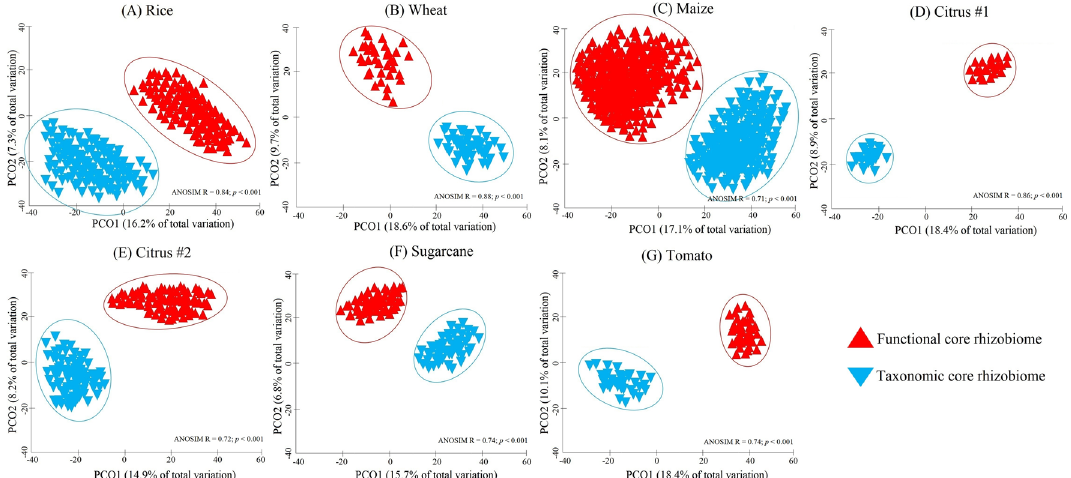
Figure 1. Principal coordinates analysis (PCoA) plots of Bray–Curtis similarities of taxonomic and functional core rhizobiomes calculated on unweighted UniFrac distances for rice ( A ), wheat ( B ), maize ( C ), citrus #1 ( D ), citrus #2 ( E ), sugarcane ( F ), and tomato ( G ). Differences in bacterial community composition between core rhizobiomes were tested by analysis of similarities (ANOSIM), and p -values < 0.01 were considered significant. R values showing the extent of bacterial community variation between core rhizobiomes are indicated, and R values close to "1.0" suggest dissimilarity between groups.